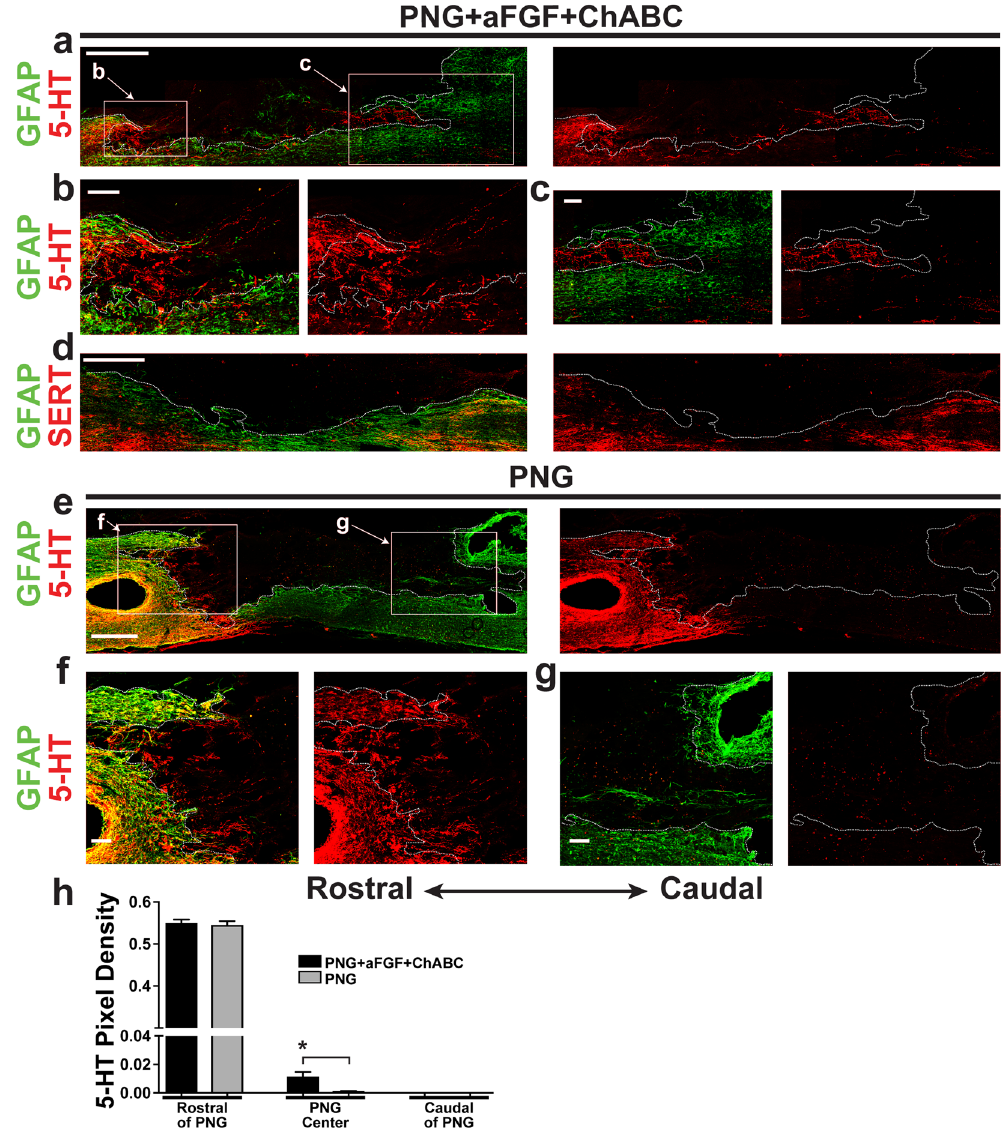
Figure 3. 5-HT + nerve fibers fail to regenerate in the chronically repaired cord. ( a – d ) Images are from PNG + aFGF + ChABC-treated animals. The dotted line in each panel delineates the interface between the graft and spinal cord. ( a ) A representative low-magnification confocal image of a sagittal section with GFAP labeling (green) and 5-HT staining (red) displaying the overall anatomy of the PNG, spinal cord, and regenerating 5-HT + axons. Scale bar, 500 µ m. ( b ) High-magnification confocal image of the rostral cord/PNG interface boxed in a. Note the small density of 5-HT + stained axons (red) entering the PNG (GFAP-negative area) from the rostral end of the spinal cord (green). Scale bar, 100 µ m. ( c ) High-magnification confocal image of the caudal PNG/cord interface boxed in a. Few 5-HT + stained axons (red) reach the distal end of the graft, and no 5-HT axons exit the graft back into the caudal spinal cord (green). Scale bar, 100 µ m. ( d ) Low-magnification confocal image of a sagittal section with GFAP labeling (green) and SERT staining (red) displaying the overall anatomy of the PNG, spinal cord, and lack of regenerating SERT + axons. Scale bar, 500 µ m. ( e – g ) Images are from PNG-treated animals. The dotted line in each panel delineates the interface between the graft and spinal cord. ( e ) A representative low-magnification confocal image of a sagittal section with GFAP labeling (green) and 5-HT staining (red) displaying the overall anatomy of the PNG, spinal cord, and regenerating 5-HT + axons. Scale bar, 500 µ m. ( f ) High-magnification confocal image of the rostral cord/PNG interface boxed in e. Note sparse 5-HT + stained axons (red) entering the PNG (GFAP-negative area) from the rostral end of the spinal cord (green). Scale bar, 100 µ m. ( g ) High-magnification confocal image of the caudal PNG/cord interface boxed in e. Note that no 5-HT + stained axons (red) reach the distal end of the graft and no 5-HT + axons exit the graft back into the caudal spinal cord (green). Scale bar, 100 µ m. ( h ) Quantification of the density of 5-HT- immunoreactive fibers found in the rostral spinal cord adjacent to the PNG, in the center of the PNG, and in the caudal spinal cord adjacent to the distal PNG. n = 6 per group. * p < 0.05, Student’s t-test. Data represent mean ±